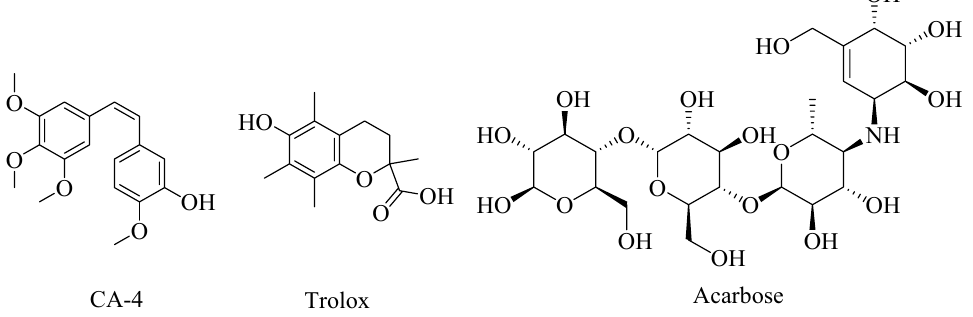
Figure 1. Structures of bioactive compounds containing a hydroxyl group.